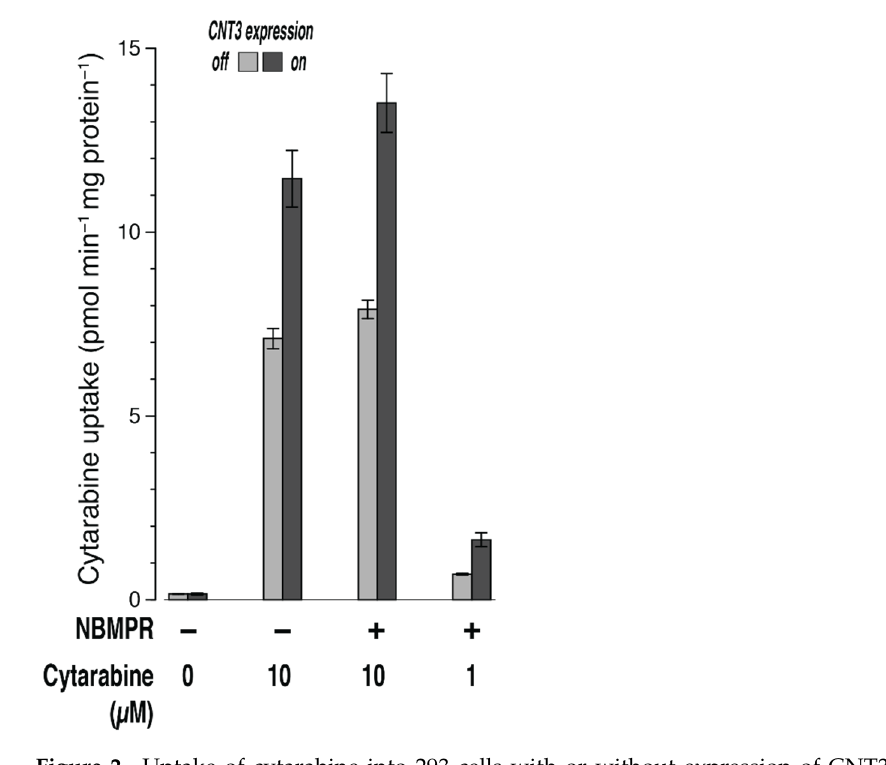
Figure 2. Uptake of cytarabine into 293 cells with or without expression of CNT3. Cells were incubated for 5 min at 37 ◦ C with 1 or 10 µ M cytarabine (plus 50 nM NBMPR as indicated) in uptake buffer or merely with uptake buffer. See legend in Figure 1 for further details.